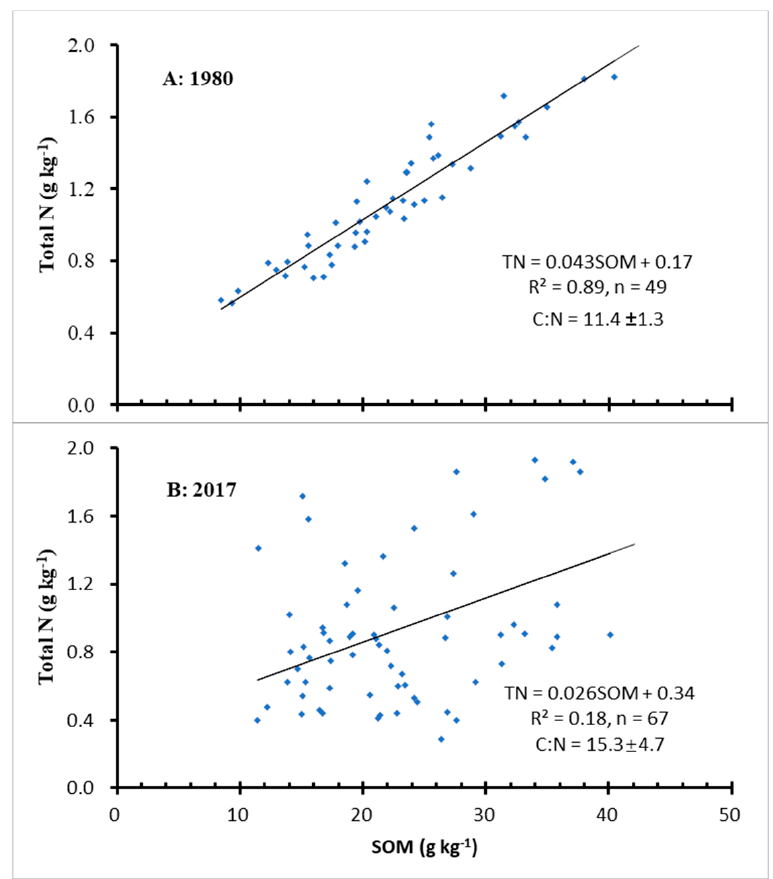
Figure 3. Correlations of soil total nitrogen (TN) to soil organic matter (SOM) in paddy fields for 1980 ( A ) and 2017 ( B ), respectively.